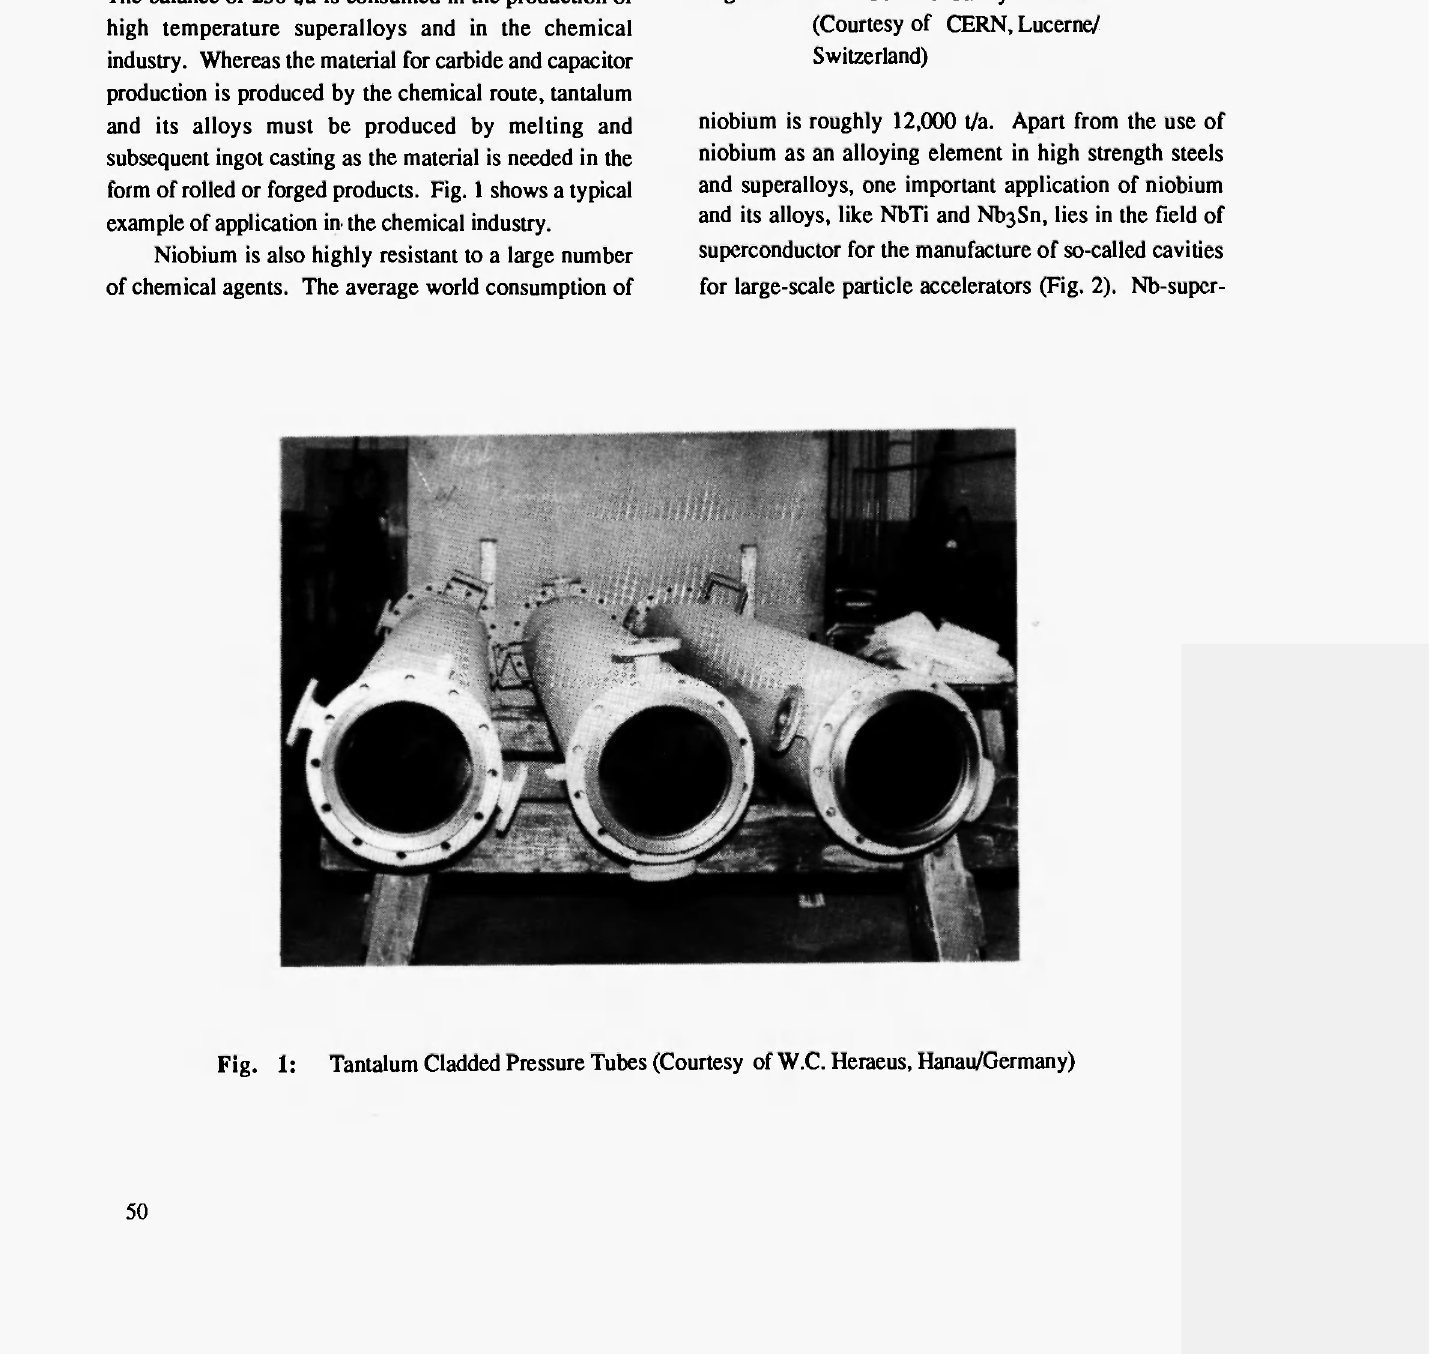
Fig. 1: Tantalum Cladded Pressure Tubes (Courtesy of W.C. Heraeus,